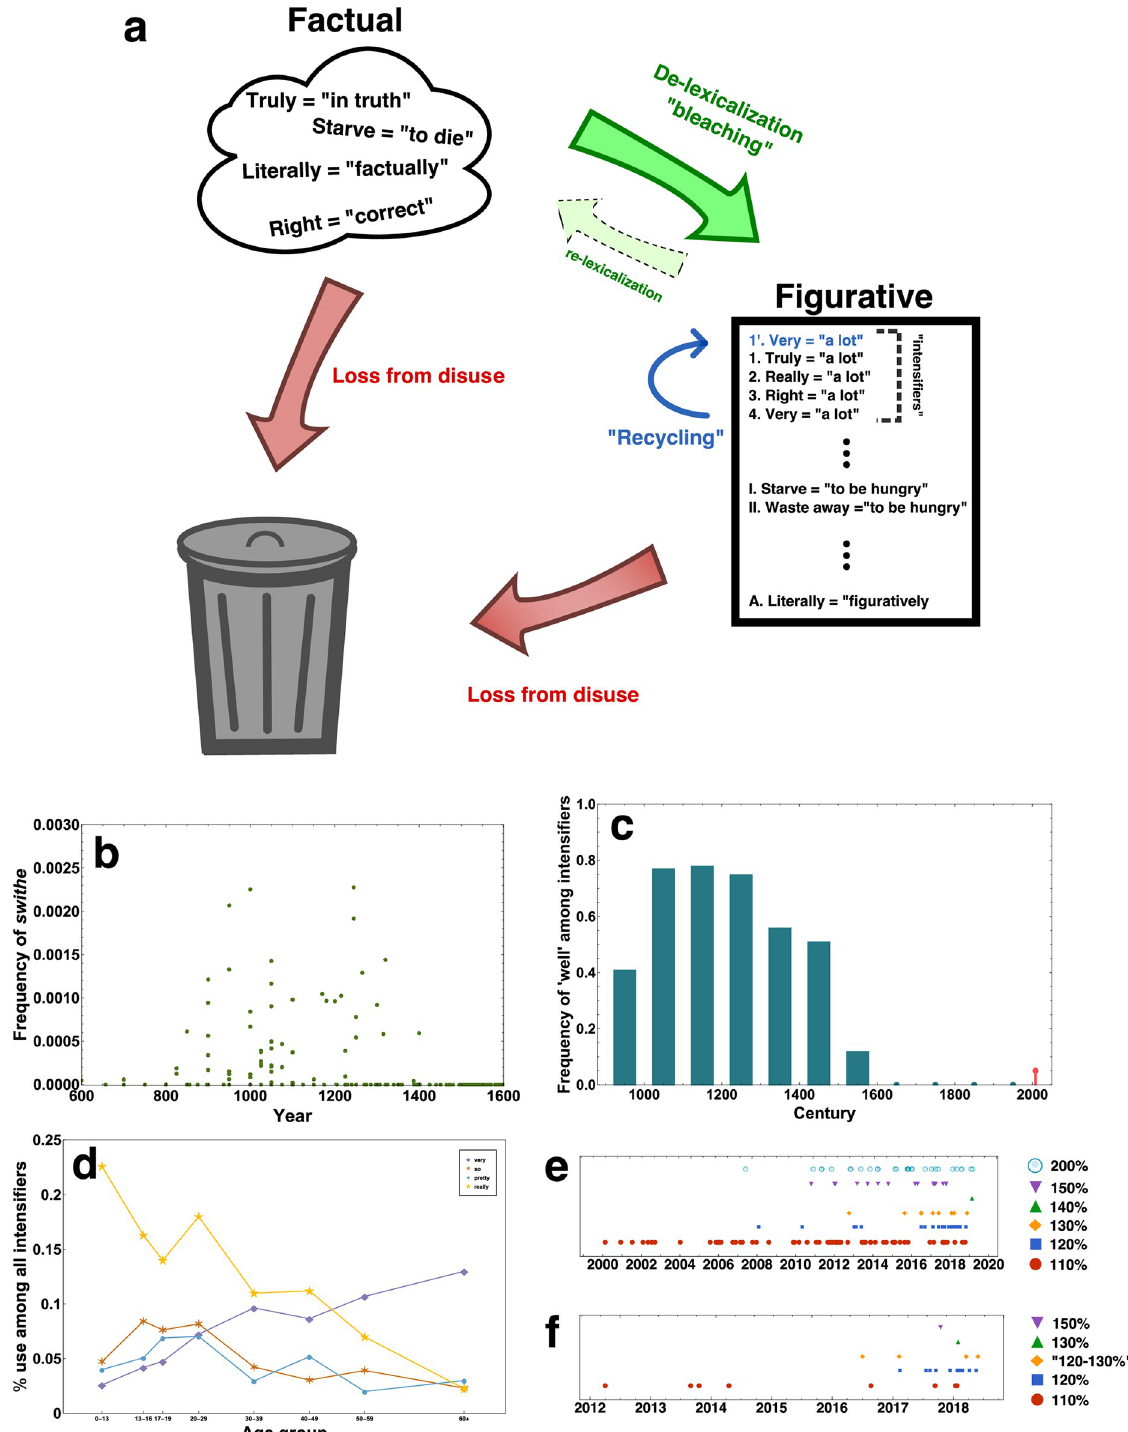
Fig 6. The life cycle of intensifiers, with empirical examples. ( a ): Most hyperbolic language originates as factual, indicative language that is then re-purposed (“de-lexicalization”, shown in green) as a figurative device. Once a word has “used up” its hyperbolic value, it decreases in usage and is supplanted either by a new bleached word or, frequently, by an older hyperbolic term whose loss of value has been forgotten by the current generation (a process called “recycling”, shown in blue). When words fall below a certain threshold of use without being recycled, they are lost from the language (red). ( b ): The rise and fall of swithe , the original English intensifer, from its de-lexicalization from